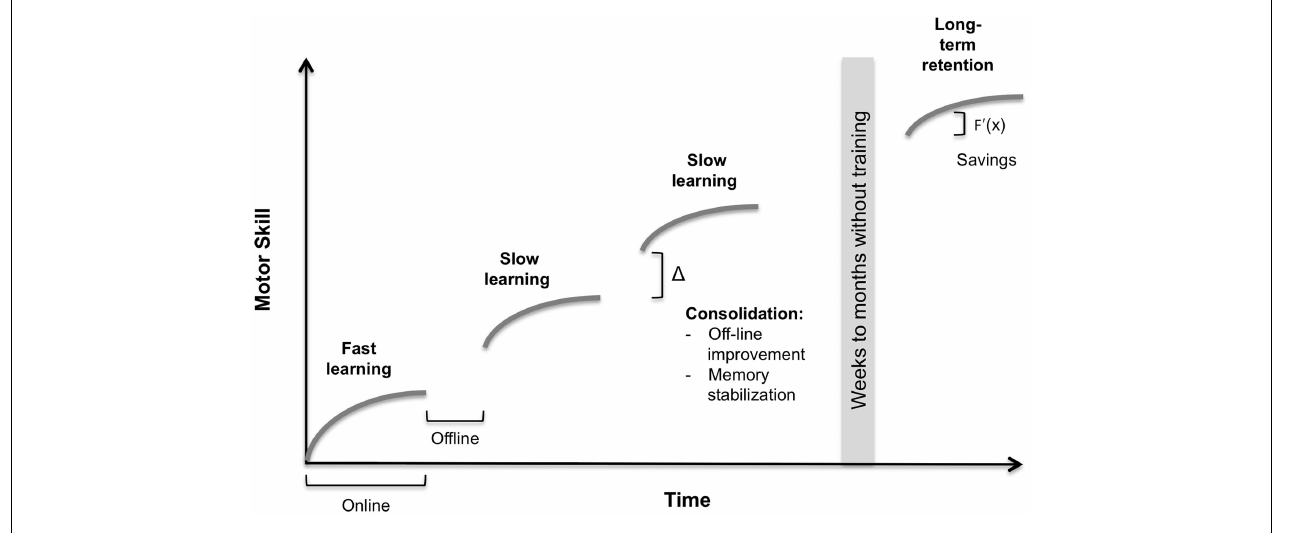
Consolidation – offline-improvement and memory stabilization. Long-term retention – skill retention after a prolonged interval. Savings – impact of previous learning on faster retraining, expressed in an increased slope f ′ ( x ) of the learning curve. For a detailed description, please see